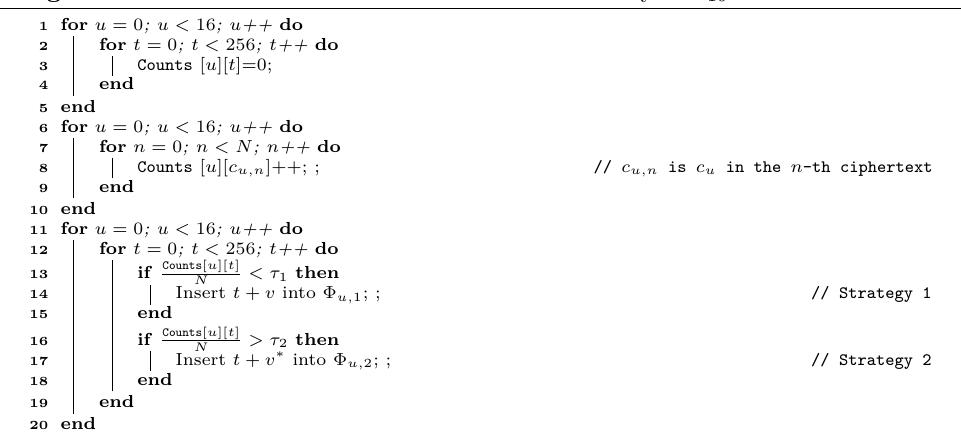
Algorithm 2: Attack on AES-128 to extract the round key in R 10 under IDDMR.